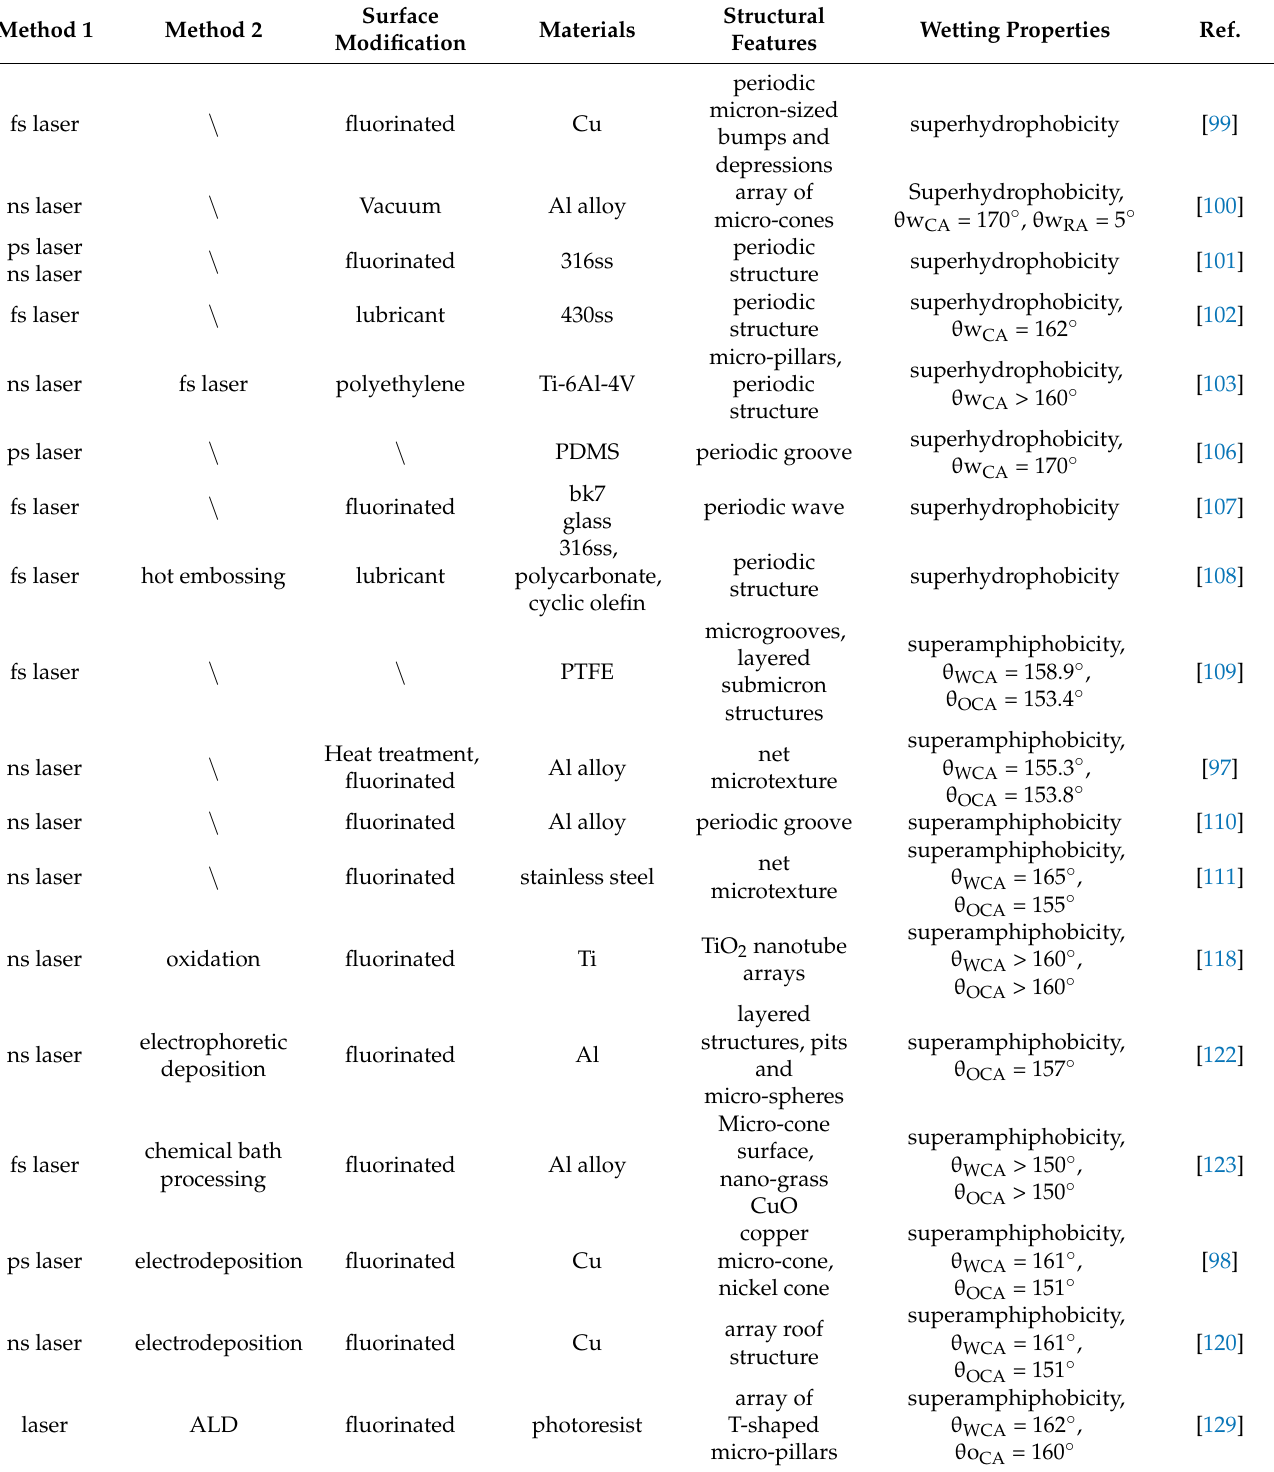
Table 1. Laser and its hybrid processing for the preparation of superhydrophobic and superam- phiphobic